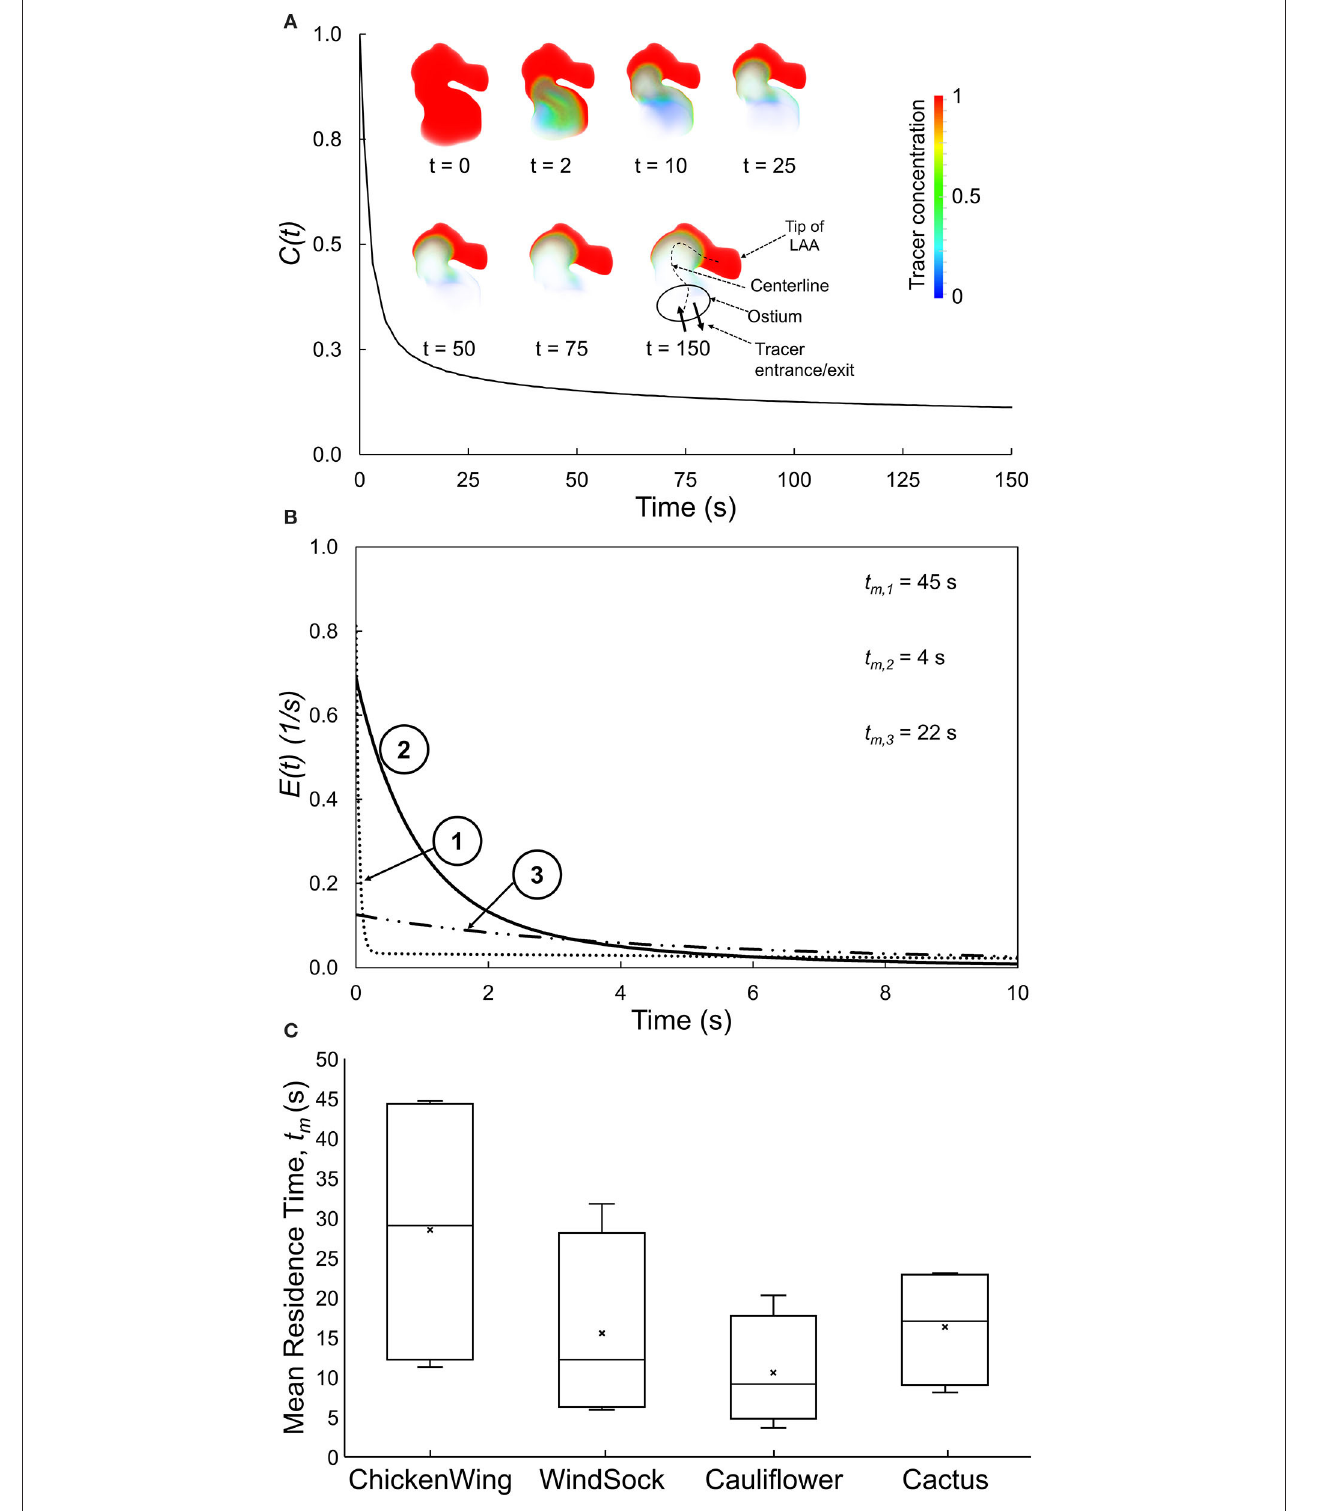
FIGURE 3 | (A) Spatially averaged LAA tracer concentration, C ( t ), plotted as a function of time for a representative LAA. Inset: Tracer concentration contours for selected time, illustrating the tracer washout from most of the LAA, except for the tip of the LAA. (B) E ( t ), the residence time distribution function quantifying the normalized rate of tracer washout across the LAA ostium, as a function of time for three representative subjects. Data for the first 10s are shown to highlight the early washout. (C) Box plots showing the mean residence time, t m , for each of the four traditional LAA shape groups. There is large variability in t m within each traditional LAA shape